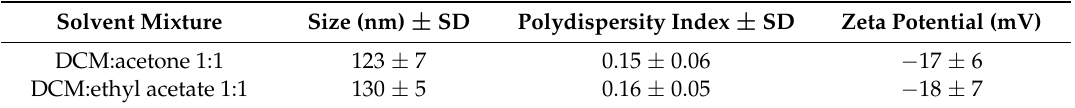
Table 1. Size, PDI, and zeta potential of nanoparticles prepared by emulsion-evaporation technique (10 mg RSG starting amount).